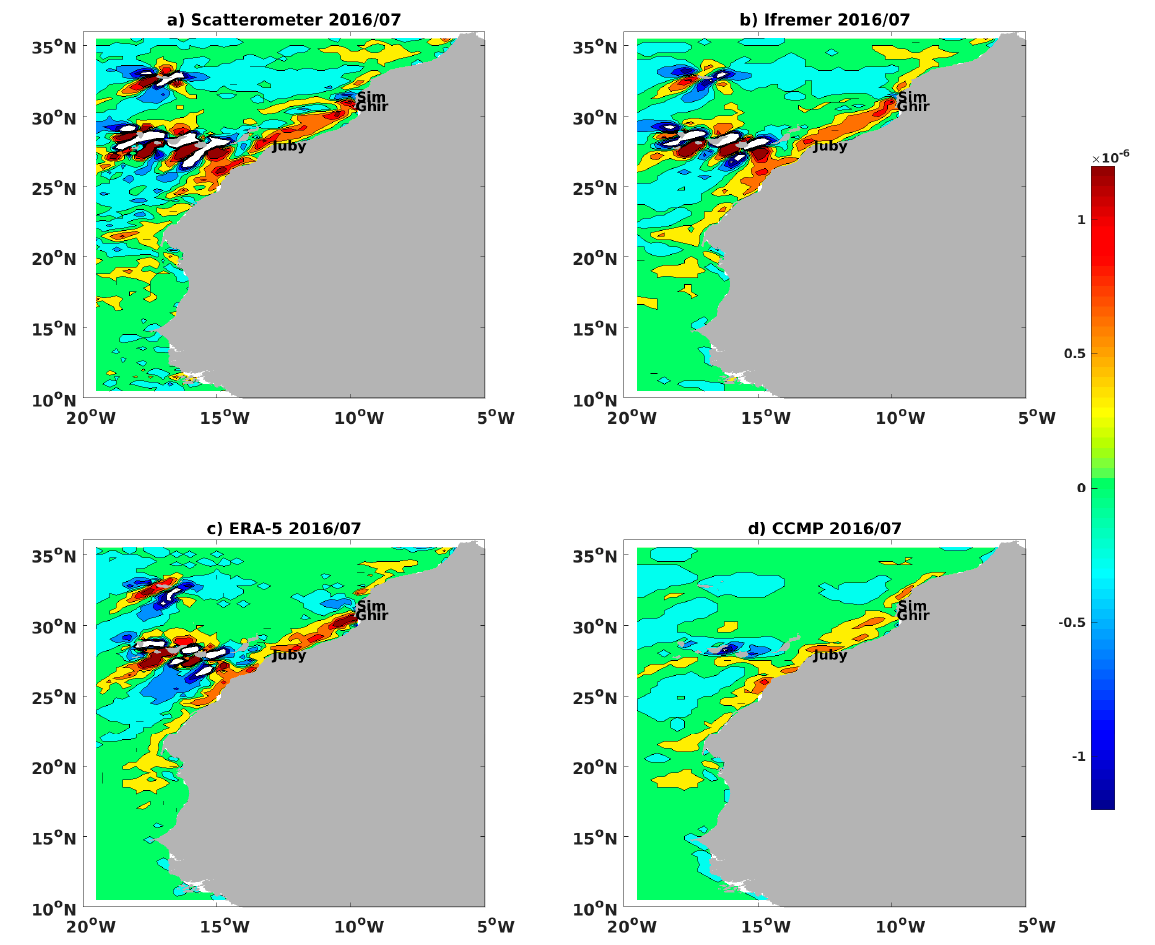
Figure 8. July 2006 mean of wind stress curl estimated from ( a ) scatterometer (QuikSCAT) and collocated ( b ) Ifremer, ( c ) ERA-5, and ( d ) CCMP analyses over the Canary zone. Colors indicate curl amplitude in N/m 3 .